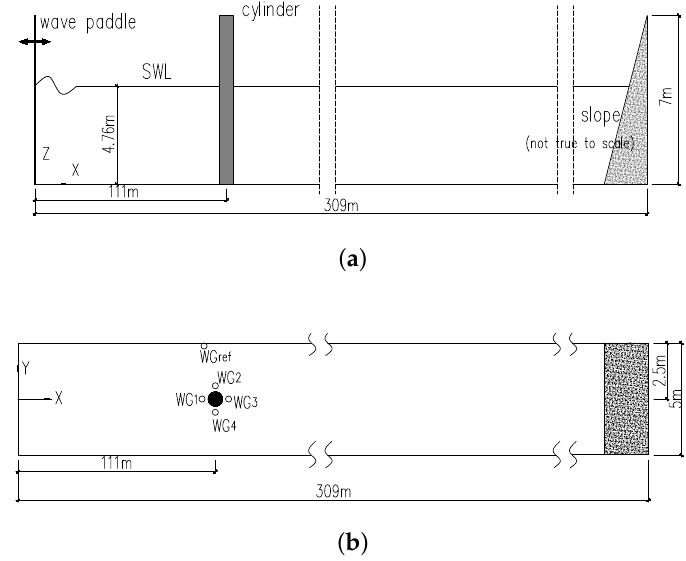
Figure 4. A sketch of the large wave flume. ( a ) Elevation of experimental setup; ( b ) Plan of experimental